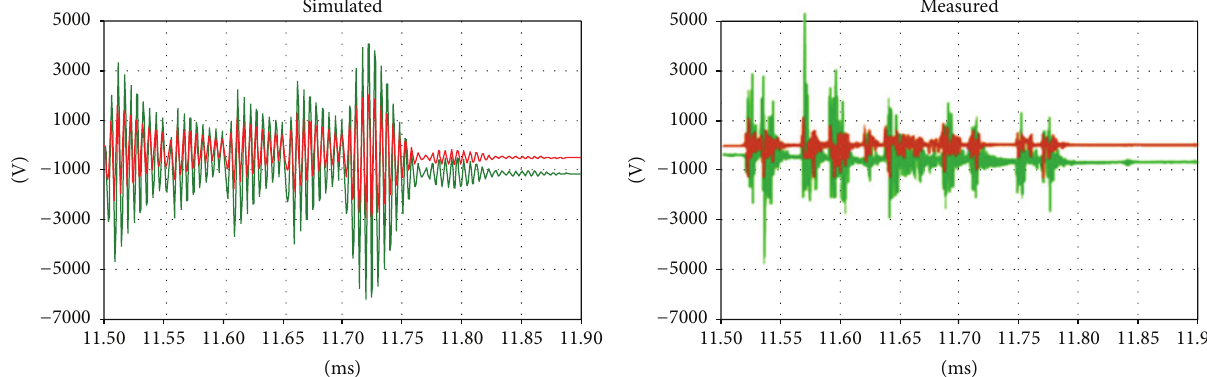
Figure 12: Details of the transient voltages on the secondary side of the transformer during the inrush; green: main coil, red: tap coil.